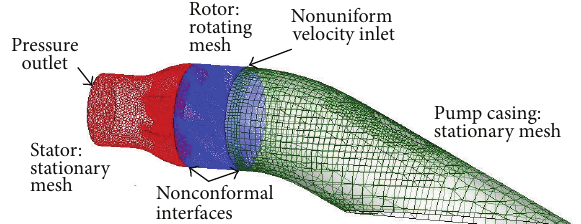
Table 3: Flow nonuniformity factors for stations 3 through